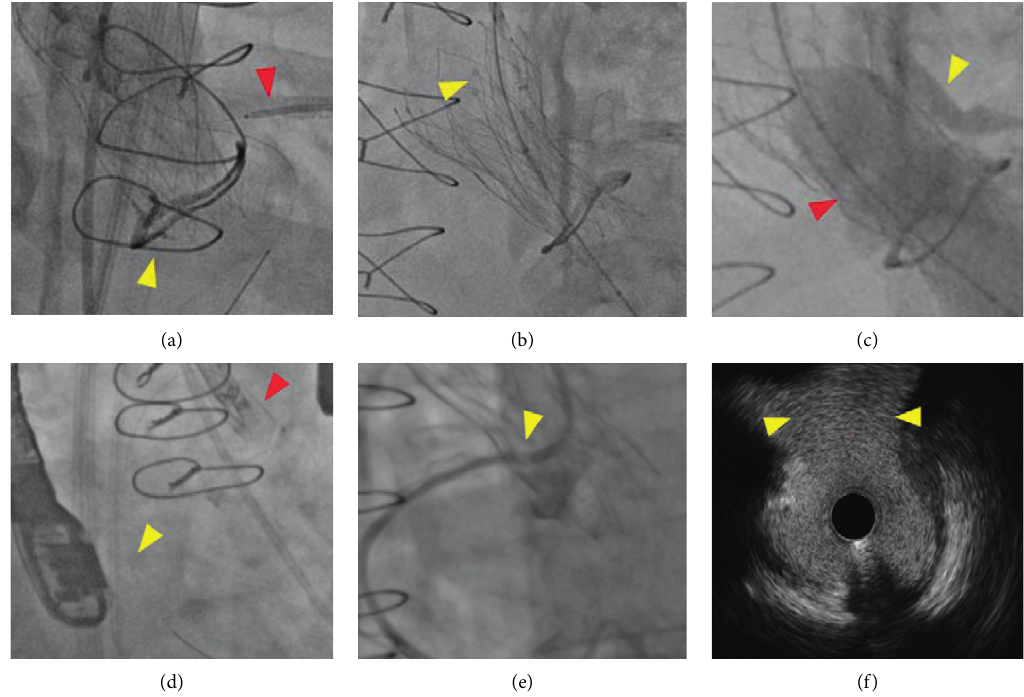
Figure 5: Coronary protection using chimney stenting (a–c) or BASILICA (d, e). (a) An 83-year-old male patient underwent transfemoral ViV-TAVI because of severe aortic regurgitation in a bioprosthetic valve of unknown type. Because of low coronary height, shallow sinuses, VTC 1mm, and advanced age, coronary protection was obtained with a wire, 6F GuideLiner, and unexpanded stent in the LAD (red arrowhead). Device malposition of a 25 mm Navitor valve occurred, resulting in severe aortic regurgitation (yellow arrowhead). (b) A second Navitor 25mm valve was implanted with a good result (double layer of markers of the Navitor valve, yellow arrowhead). (c) Chimney stenting was performed using a Synergy Megatron 4.0 × 20 mm DES with kissing balloon inflation with 6.0 × 20 mm Emerge NC (yellow arrowhead) and 22 mm True balloon (red arrowhead). (d) A 63-year-old female patient underwent transfemoral ViV-TAVI in a 21mm Trifecta valve. Because of low right coronary ostium (10mm), VTC of 3mm, shallow sinuses, and externally mounted leaflets, the right coronary was protected with a wire (yellow arrowhead) and 6F GuideLiner (temporarily retracted in the 6 F guiding catheter). Because of the young age, a BASILICA procedure was performed upfront (red arrowhead, set up before leaflet laceration with an 8 F traversal MP1 guiding catheter with Astato XS 20 wire inside the PiggyBack wire converter and snared Astato wire inside a 6F MP guiding catheter). (e) Haziness at the right coronary ostium after successful implantation of a Navitor 23mm valve 4mm below the fluoroscopic ring. (f) IVUS showing a nice opening at the level of the right coronary ostium towards the aorta (yellow arrowheads) BASILICA: bioprosthetic aortic scallop intentional laceration to prevent iatrogenic coronary artery obstruction; IVUS: intracoronary vascular ultrasound; DES: drug-eluting stent; VTC: virtual transcatheter to coronary distance.